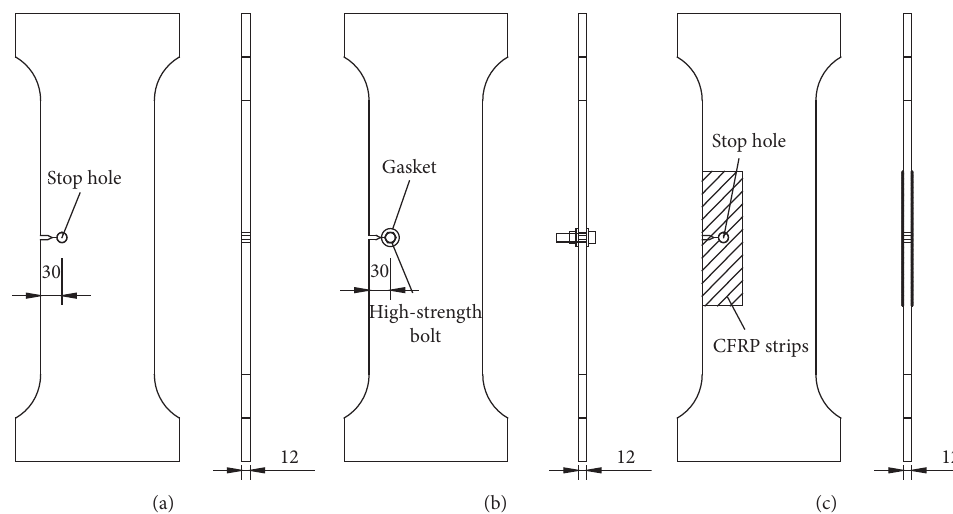
Figure 2: Dimensions of strengthened steel plates with various repair methods (mm). (a) Stop-hole repair group. (b) High-strength bolt stop-hole group. (c) Highmodulus CFRP repair group.